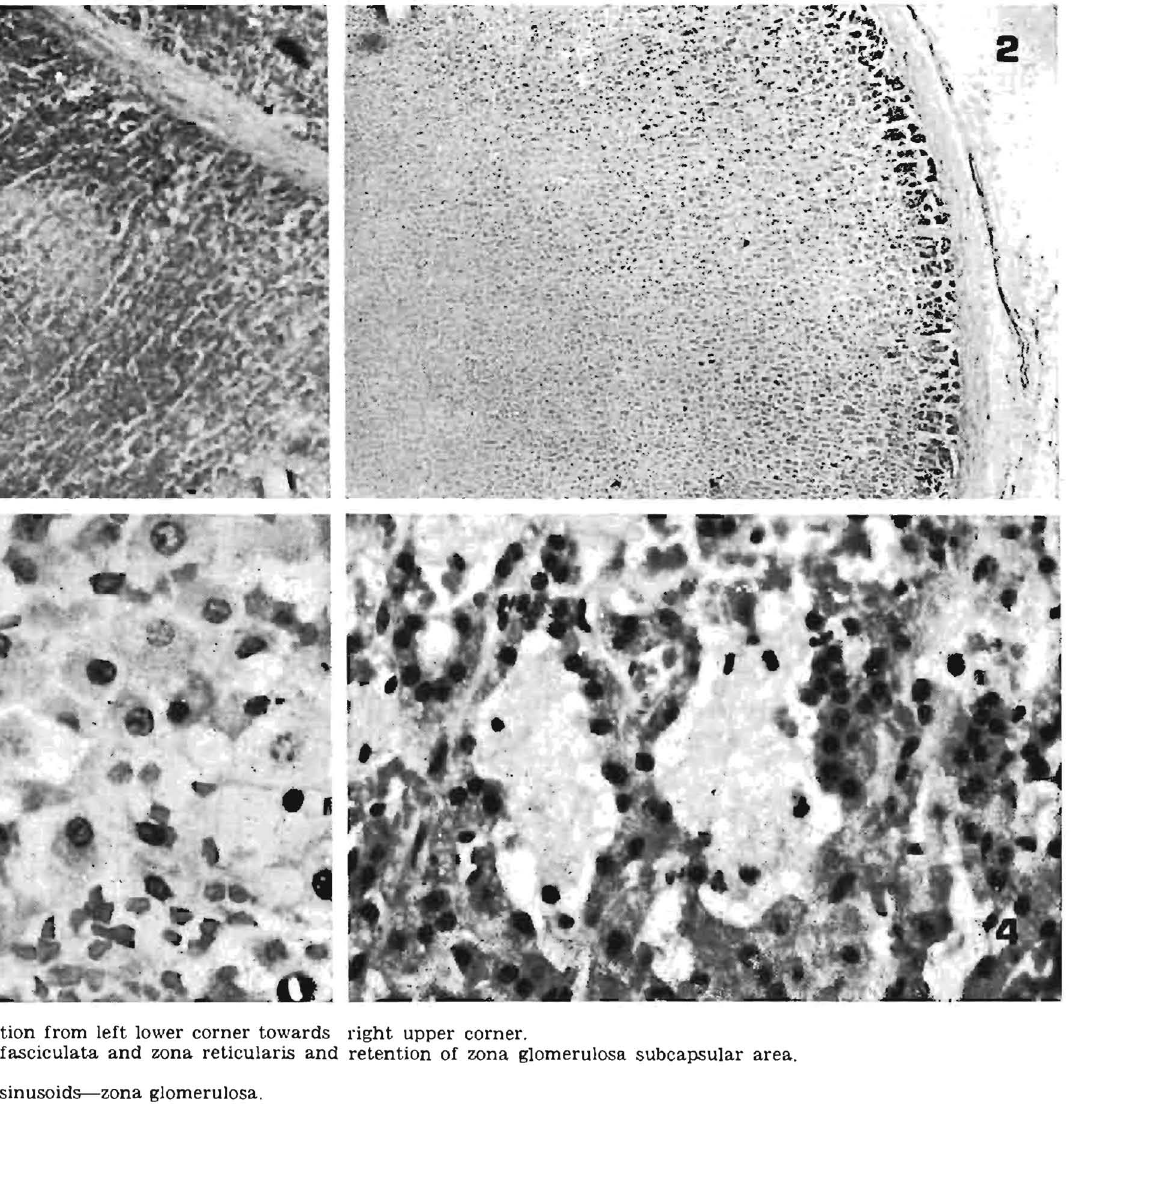
FIG. 1: H. & E. 250 x Segmental infarction from left lower corner towards right upper corner. FIG. 2 H. & E. 100 x Necrosis of zona fasciculata and zona reticularis and retention of zona glomerulosa subcapsular area. FIG. 3 H. & E. 600 x Toxic cytolysis. FIG. 4 H. & E. 600 x Fibrin thrombi in sinusoids---zona